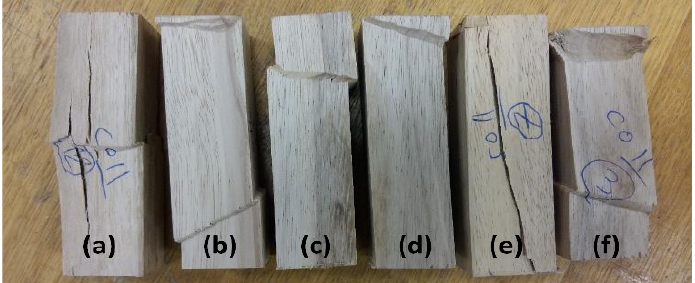
Figure 9. Failure modes of the CPA samples. ( a , e ) compression and shearing parallel to grain, ( b , f ) end-rolling and shearing, ( c , d )